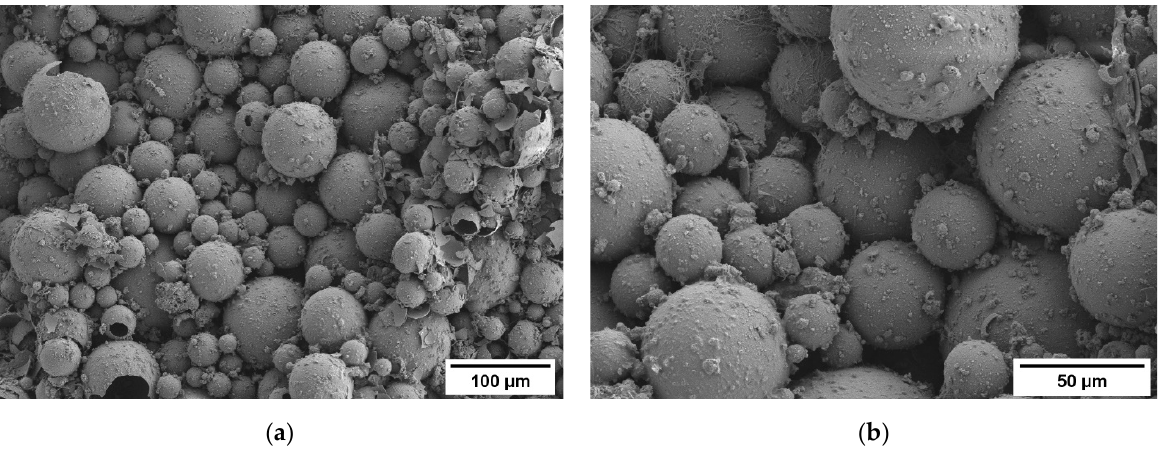
Figure 6. SEM images of a fractured surface after three ‐ point bending tests of the hydrated sample 30C, with 70 wt.% HGMSs and 30 wt.% CSA cement. The acceleration voltage was set to 5 kV, while